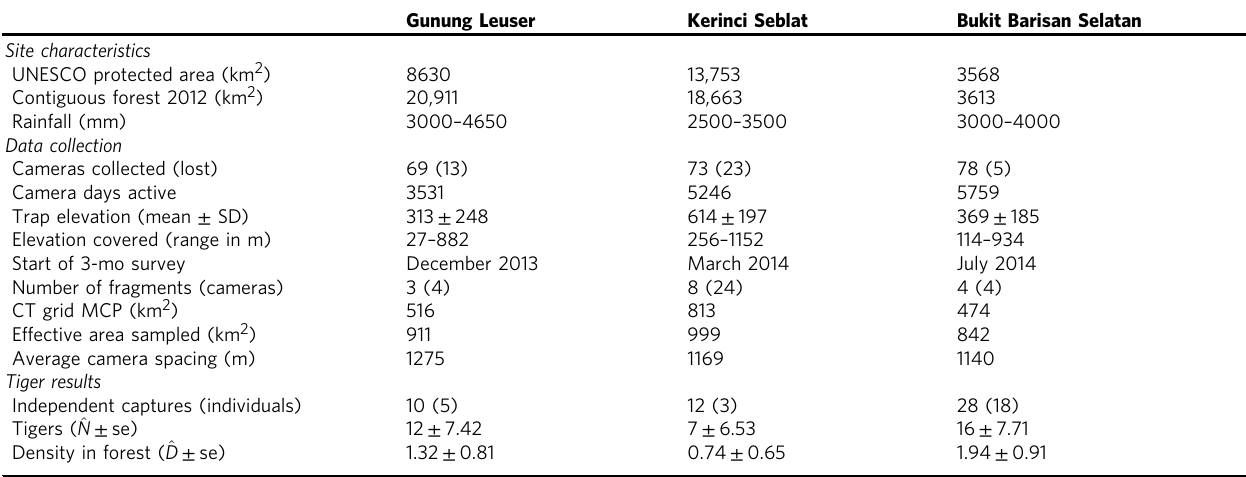
Table 1 Site characteristics and